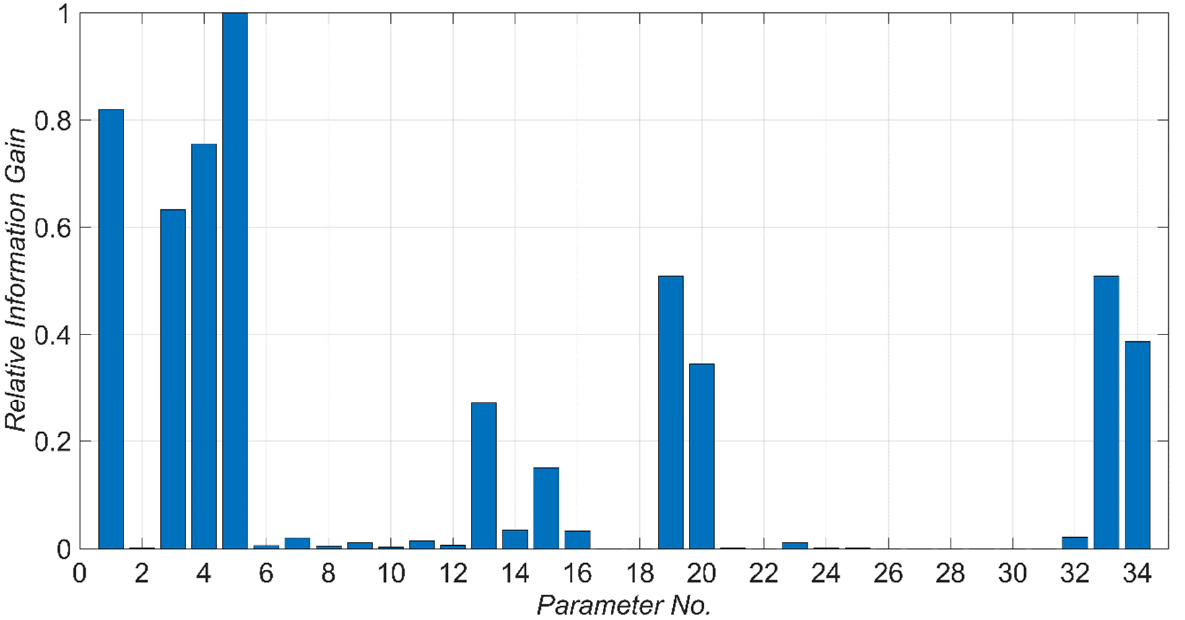
Figure 7. Relative information gain of model parameters. Parameters are defined in Table 2.